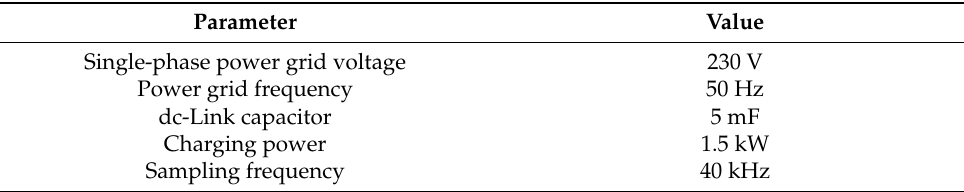
Table 3. Battery-charging simulation parameters in G2V mode.